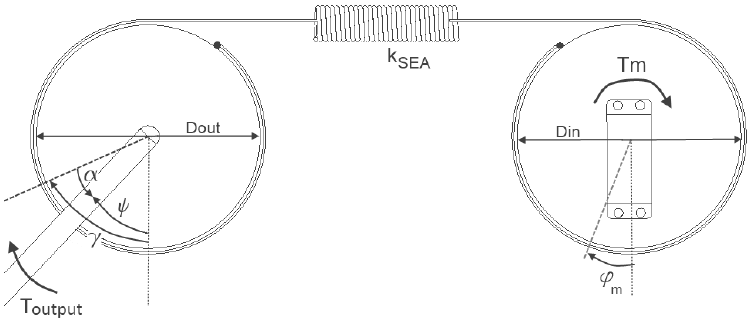
Figure 2. All the relevant parameters of the SEA agonistic drum-drum set-up indicated on a scheme. On both the input drum ( right ) and the output drum ( left ), a wire is fixed, which are each connected to one of both sides of an extension spring.